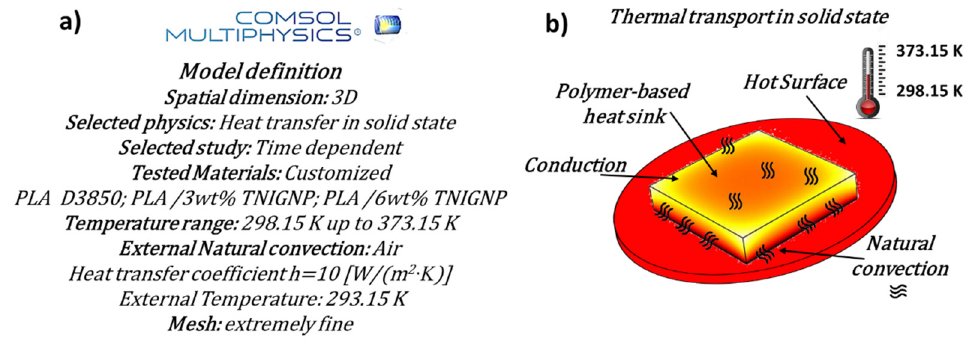
Figure 3. Main model definitions for the numerical study on the thermophysical properties of polymer-based heat sinks ( a ). Schematic representation of the numerical case study ( b ).